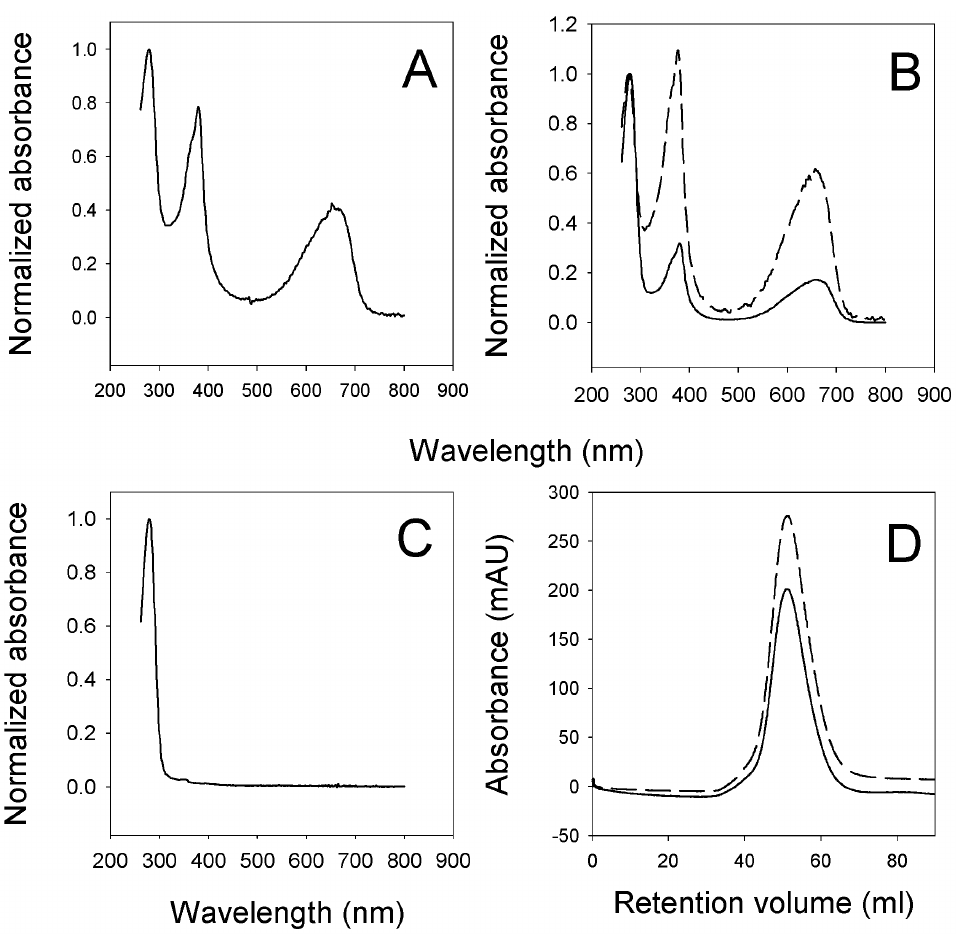
Figure 4. Analysis of ligand binding to BBPLo. (a) Spectral analysis of BBPLo from L.obliqua spicule extract using a combination of gel filtration chromatography on Superdex 75 and diode array detection. The spicule extract was injected on to the column and a full absorbance spectrum was obtained at the retention time corresponding to the elution peak of BBPLo. (b) Analysis performed as in (a) of purified recombinant protein after incubation with a sub-saturating and saturating quantities of biliverdin IX c obtained by extraction of M. sexta insecticyanin. Solid line : Recombinant BBPLo (0.91 m M) was incubated with biliverdin IX c (0.4 m M) prior to chromatography on Superdex 75. Dashed line : Recombinant BBPLo (0.91 m M) was incubated with biliverdin IX c (1.3 m M) prior to chromatography. (c) Analysis of biliverdin IX a binding using identical methods as in panel a. (d) Heme binding to BBPLo. An excess of hemin dissolved in DMSO was incubated with recombinant BBPLo. After centrifugation the complex was purified on a Sephacryl S-100 column and absorbance was monitored at 280 (solid line) and 402 (dashed line) nm.